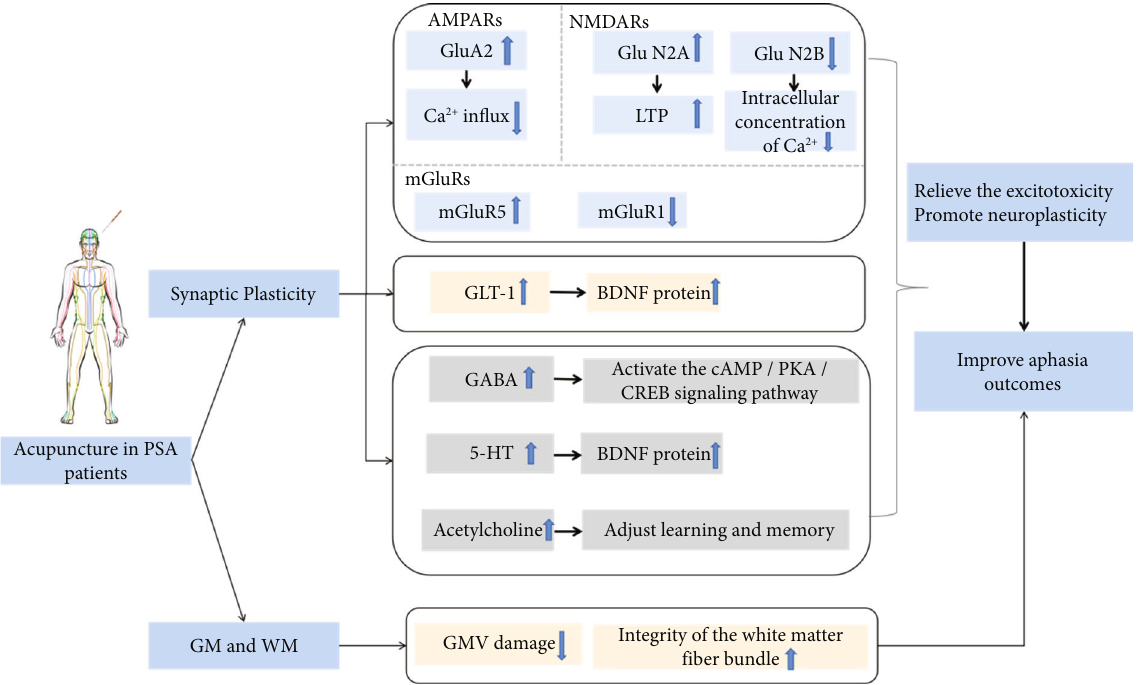
Figure 4: The possible positive e ff ect of acupuncture on PSA. AMPAR: α -amino-3-hydroxy-5-methyl-4-isoxazole-propionic acid receptor; NMDAR: N -methyl-D-aspartate receptor; Ca 2+ : calcium ion; mGluR: metabotropic glutamate receptor; GLT-1: glial glutamate transporter- 1; BDNF: brain-derived neurotrophic factor; LTP: long-term potentiation; GABA: γ -aminobutyric acid; 5-HT: 5-hydroxytryptamine; GM: gray matter; WM: white matter; GMV: gray matter